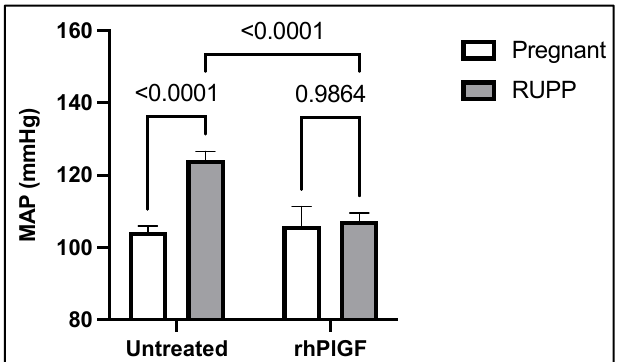
Figure 3. Effects of treatment with recombinant human placental growth factor (rhPlGF) on blood pressure responses in pregnant rats with reduced uterine perfusion pressure (RUPP). Rats were subjected to the RUPP procedure on gestational day 14. Rats were administered rhPlGF (180 μ g/kg per day, I.P. osmotic minipump) from gestational day 14–19. Conscious mean arterial blood pressure (MAP) was measured on day 19. p -Values appear in the above brackets. Mean ± SEM. Data adapted from [116].